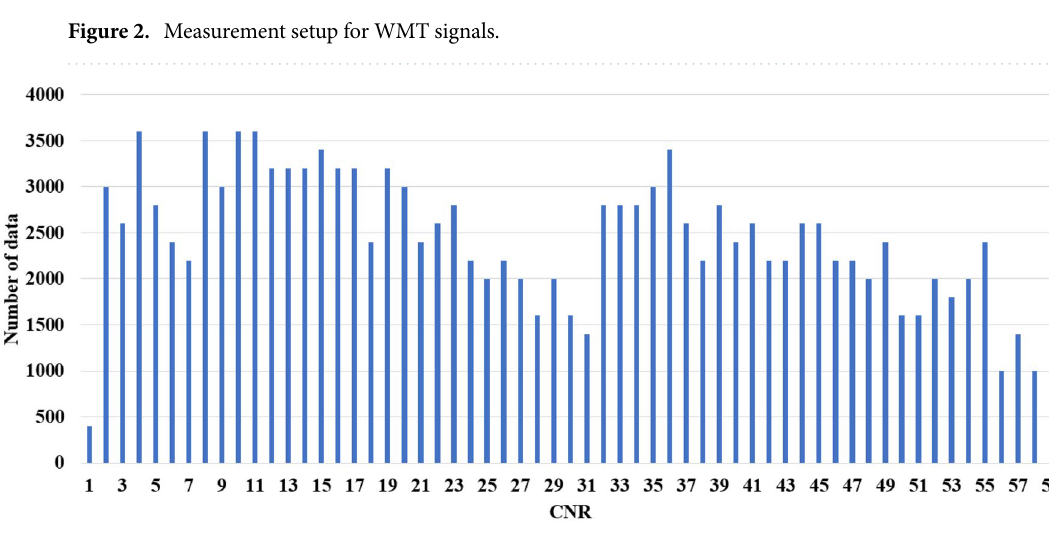
Figure 3. CNR distribution of the measured